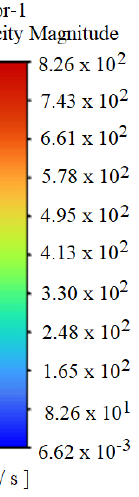
Figure 3. Velocity vector diagram for conventional and modified nozzles.